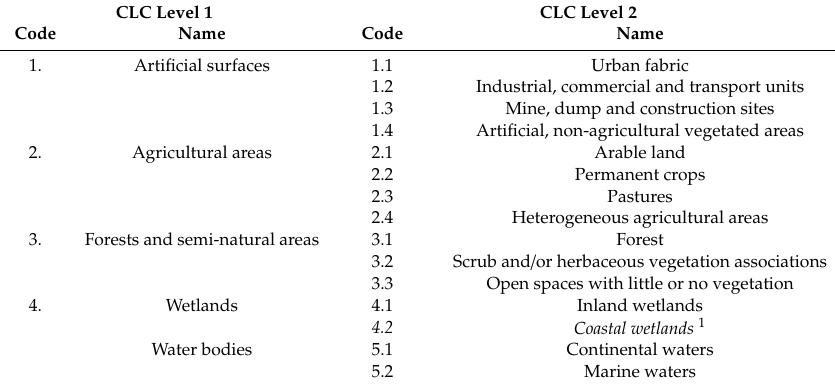
Table 3. CORINE Land Cover nomenclature (level 1 and level